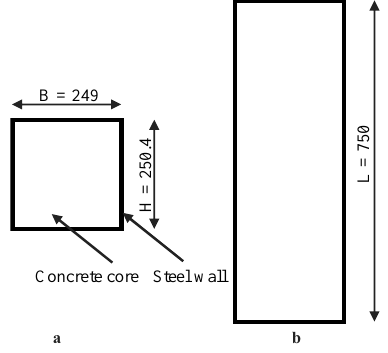
Fig. 1. Unstiffened CFSC stub column: (a) cross section; (b) elevation, (unit: